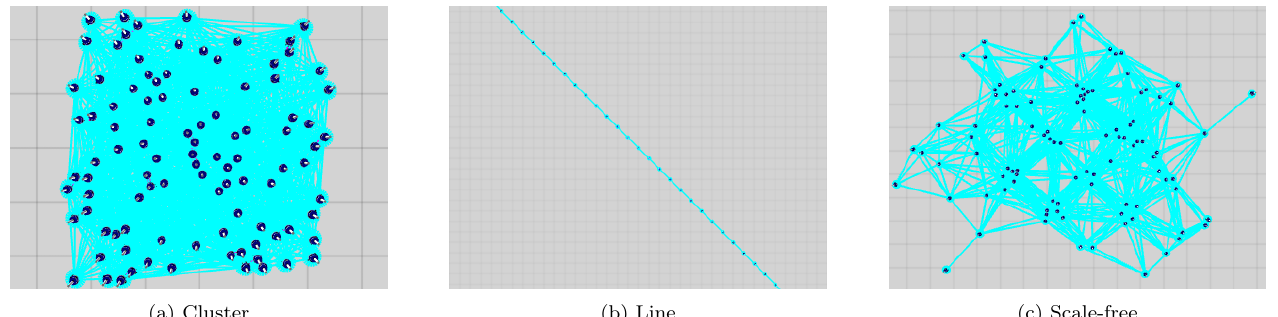
Figure 2: Robot distribution for different topologies in the experiments discussed in Section 4.1. The cyan lines connect robots within each others’ communication range and in direct line-of-sight. Screenshot taken with the ARGoS multi-robot